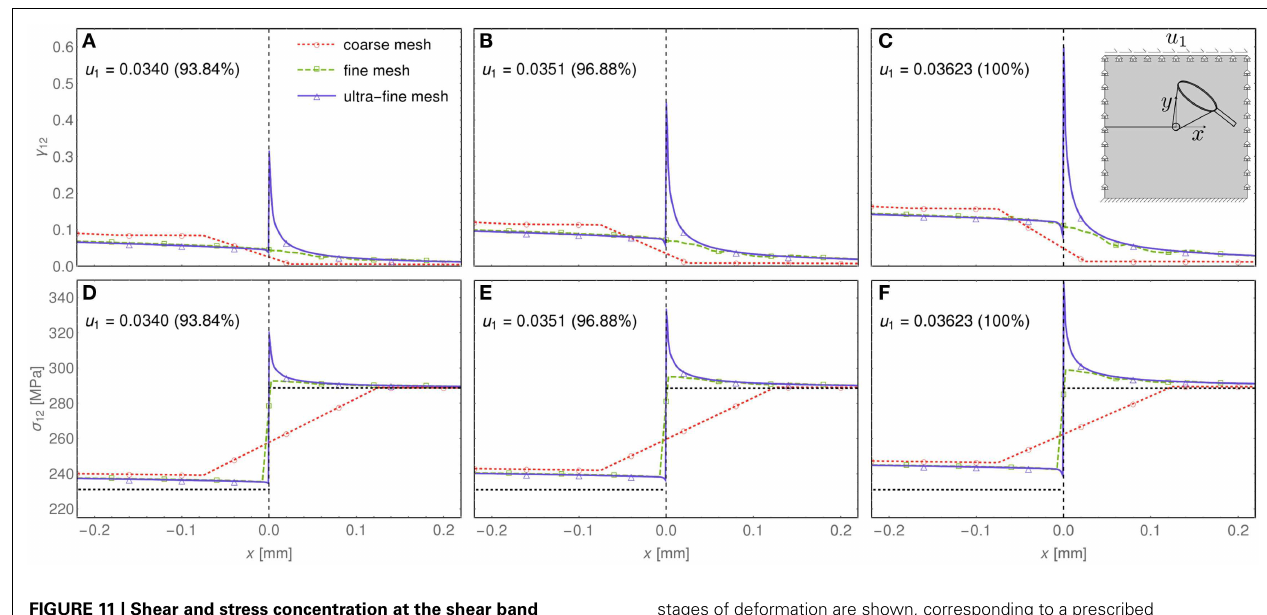
FIGURE 11 | Shear and stress concentration at the shear band tip . Shear deformation γ 12 (A–C) and shear stress σ 12 (D–F) along the x -axis containing the pre-existing shear band for the case of a material close to a shear band instability E p = 300MPa.Three different